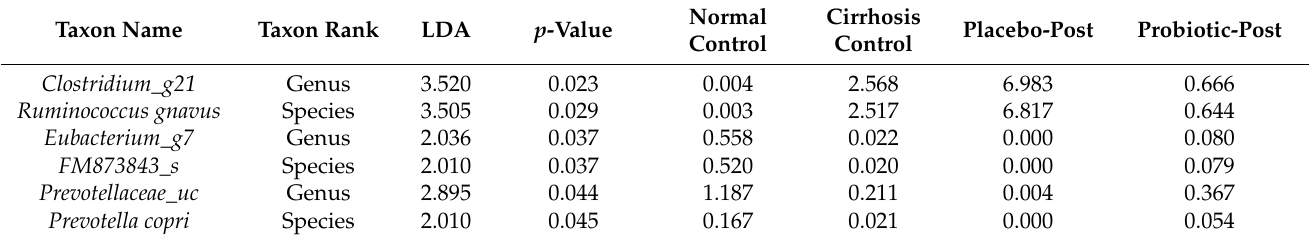
Table 3. Changes in taxonomic relative abundance according to LDA score among the groups.